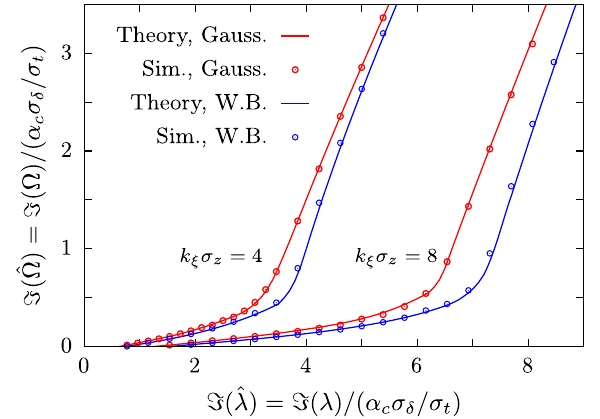
FIG. 10. Comparison of the maximum growth rate for Gaussian (Gauss.) and waterbag (W.B.) equilibriums, assuming that the longitudinal potential is simple